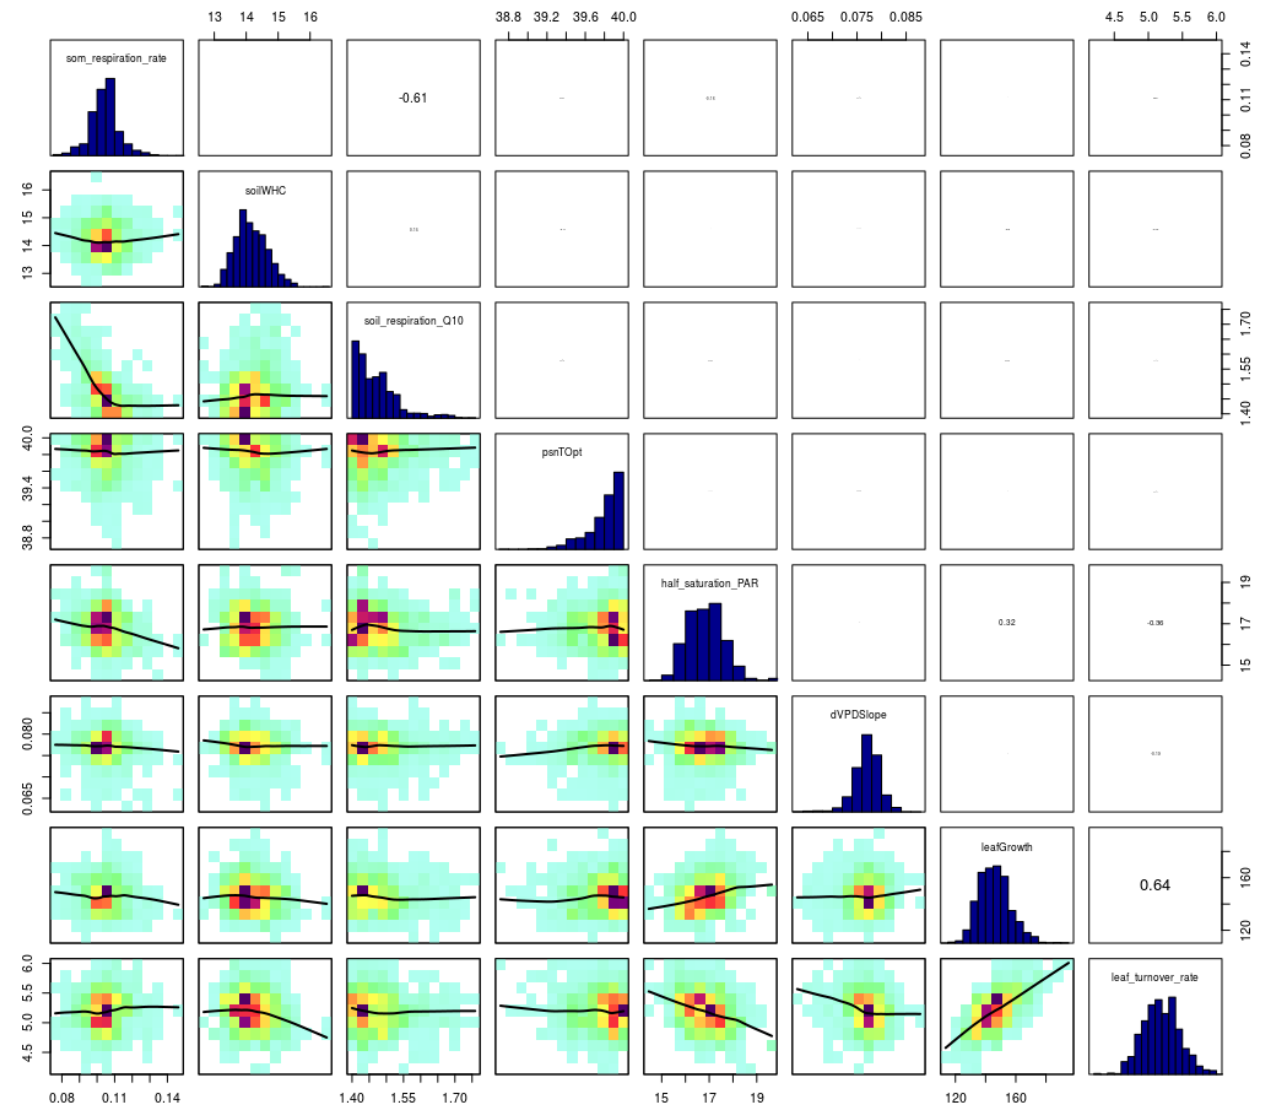
Figure A4. Correlations in the posterior samples after brute-force MCMC